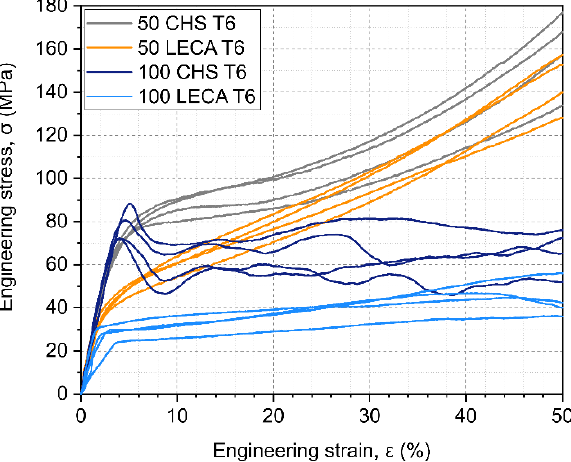
Figure 6. Engineering stress – engineering strain curves of the samples. The evaluated results of the measurements are shown in Figure 7.